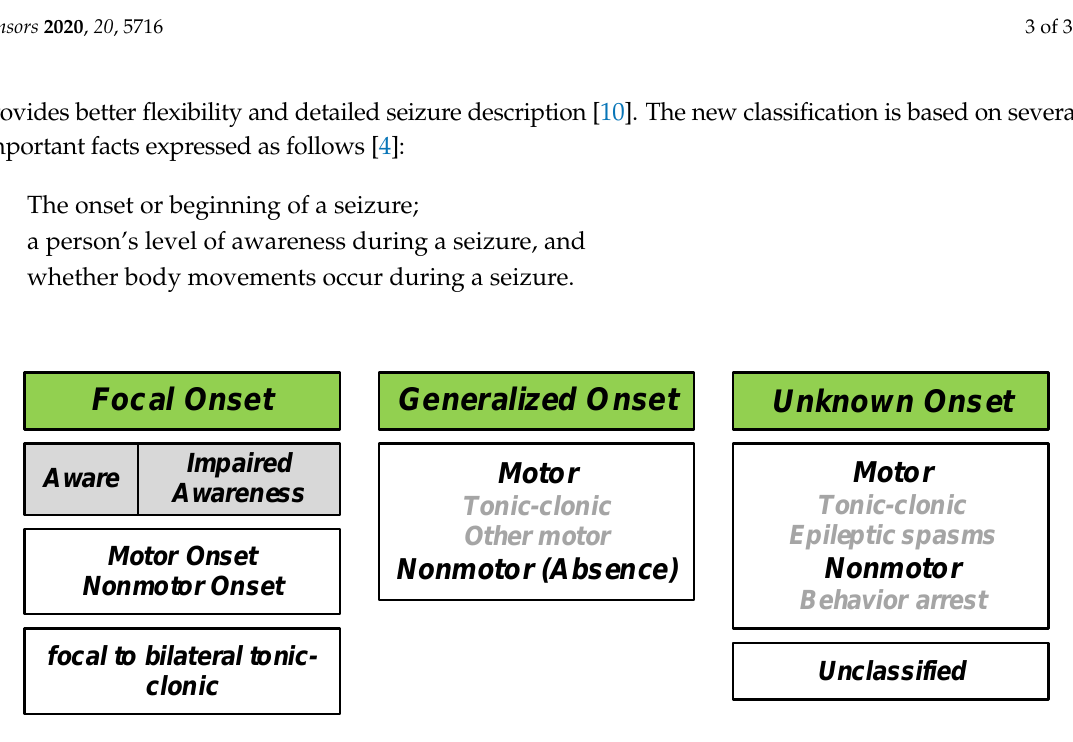
Figure 1. The new classification of seizure types based on the International League Against Epilepsy (ILAE) report (Reprinted with permission of Wiley Periodicals, Inc. © 2017 International League Against Epilepsy)